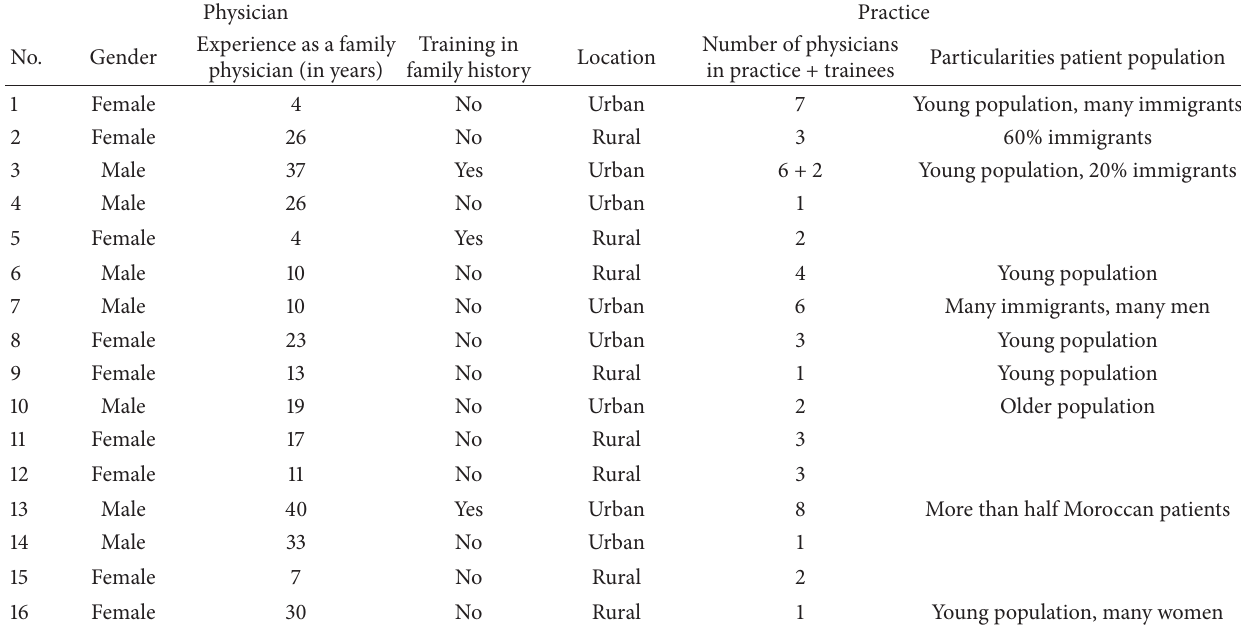
Table 1: Characteristics of the